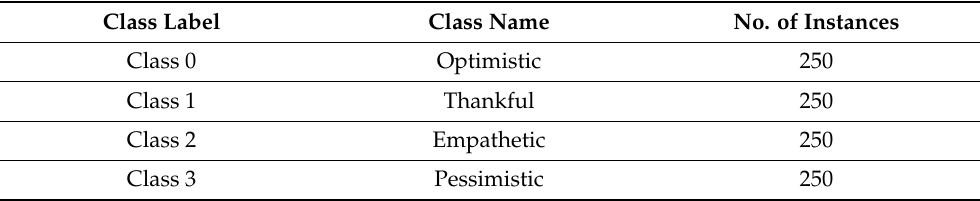
Table 1. Dataset